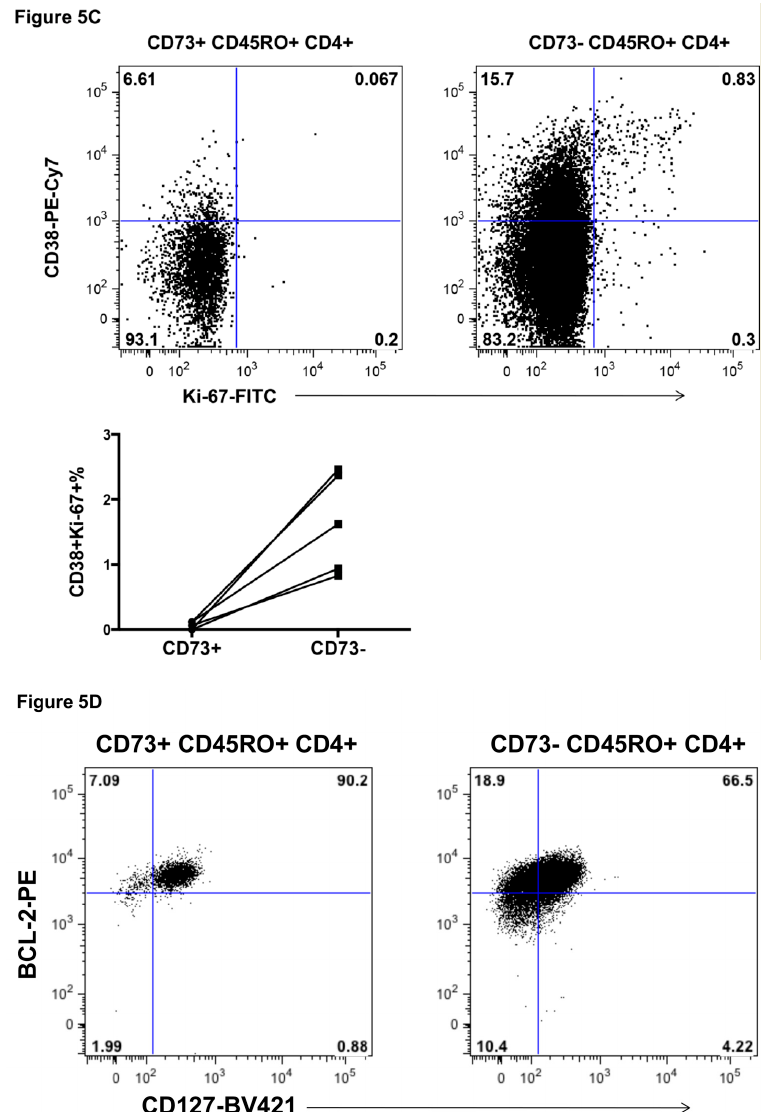
Figure 5. Proliferation of CD73+ CD4+ T cells in vitro, but not in vivo. ( A ) Representative flow plots showing the proliferation of CD73+ CD4+ T cells (top row) and CD39+ CD4+ T cells (bottom row) within PBMC after 7 days culture with IL-7 or IL-2. Results are representative of 3 experiments. ( B ) Representative flow plots showing the proliferation of CD73+ CD8+ T cells (top row) and CD39+ CD8+ T cells (bottom row) within PBMC after 7 days culture with IL-7 or IL-2. Results are representative of 3 experiments. ( C ) Representative flow plots of CD73+ CD4+ T cells in fresh peripheral blood, showing that CD73+ CD45RO+ memory CD4+ T cells have very low levels of the activation antigen CD38 and an intracellular marker of cell cycling Ki-67, compared CD73-negative CD45RO+ memory CD4+ T cells. Bottom graph shows summary data from n = 5 healthy adults. ( D ) Representative flow plots showing coexpression of CD127 and antiapoptotic intracellular marker Bcl-2 in CD73+ CD45RO+ memory CD4+ T cells compared to CD73-negative CD45RO+ memory CD4+ T cells. Results are representative of 3 experiments.